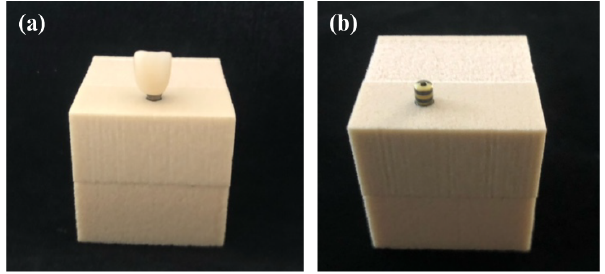
Figure 2. Creation of research models. ( a ) Provisional crown group. ( b ) Healing abutment group.